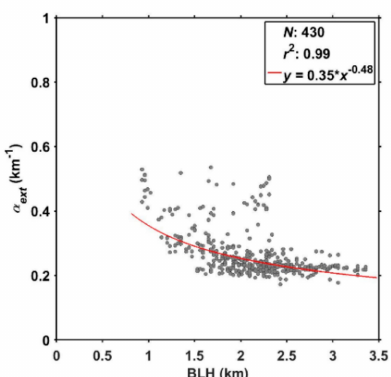
Figure 7. Relation between near-surface α ext (349 nm) and the boundary layer height (BLH) (National Institute for Environmental Studies (NIES) lidar) observed in the November 2017 campaign. The values of α ext were averaged to 15 min and rainy days were excluded. The value of r 2 is based from the least absolute residuals (LAR) regression